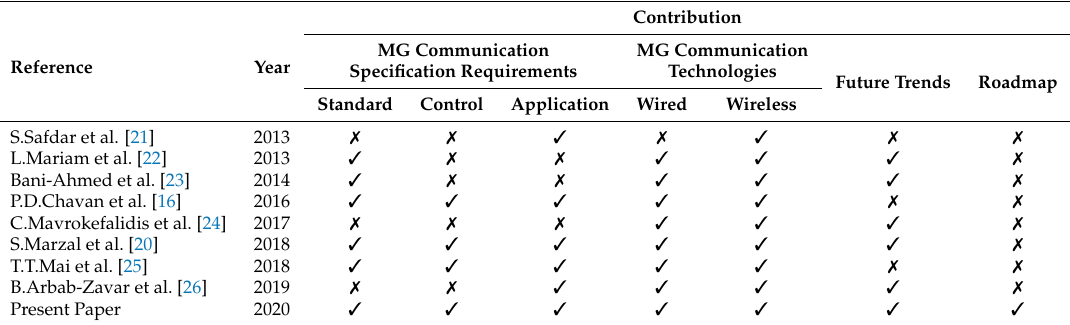
Table 1. Present and related works—a